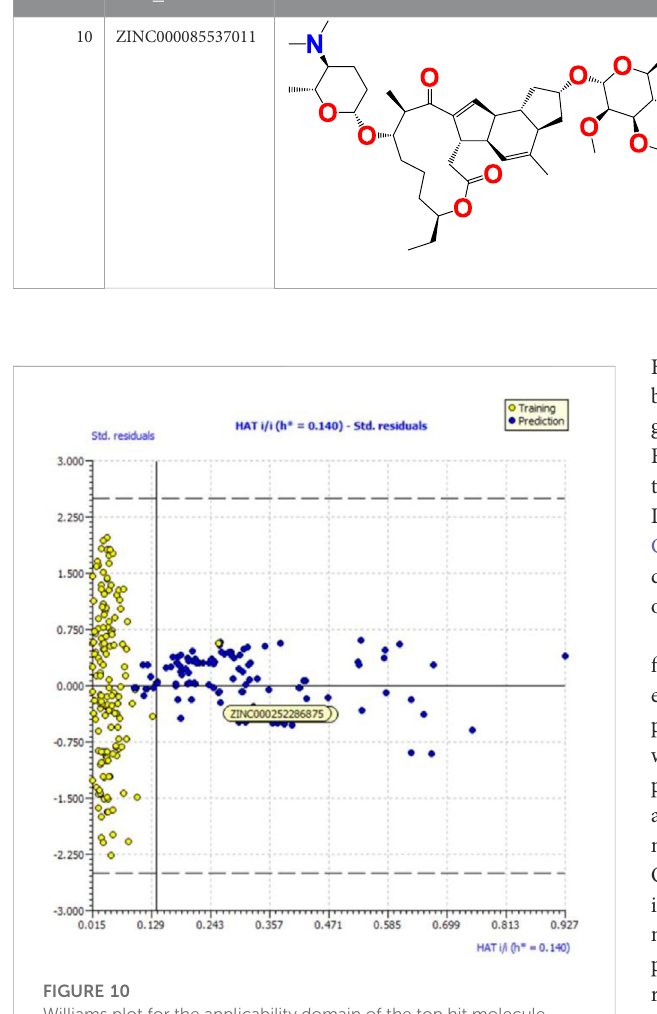
FIGURE 10 Williams plot for the applicability domain of the top hit